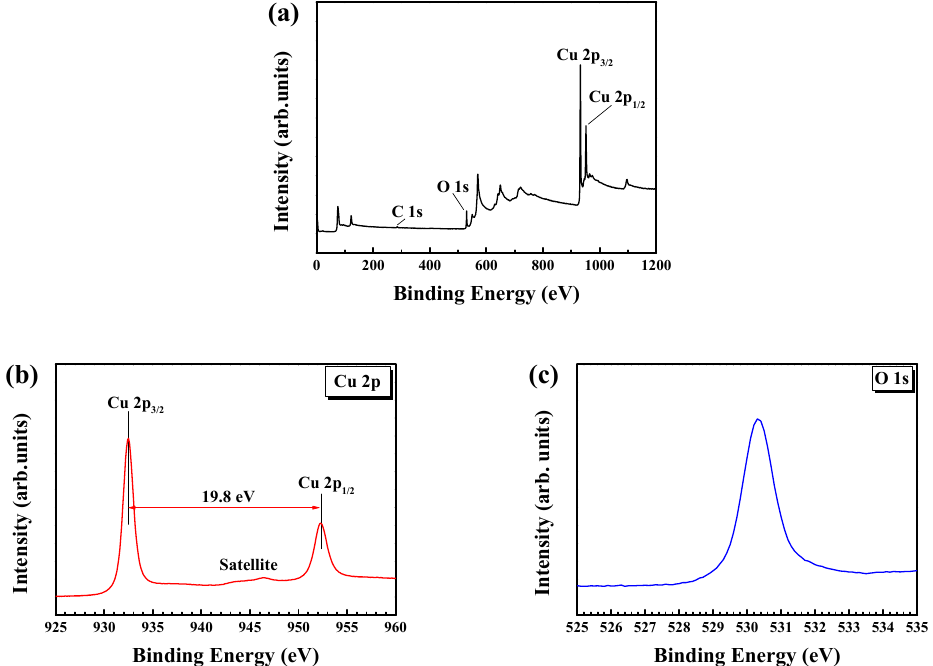
Figure 3. XPS spectra of a Cu 2 O thin film grown at a substrate temperature of 400 °C; ( a ) all surveyed spectra, ( b ) Cu 2p, and ( c ) O1s peaks. Table 2. XPS analysis results for Cu 2 O thin films deposited at various substrate temperatures.